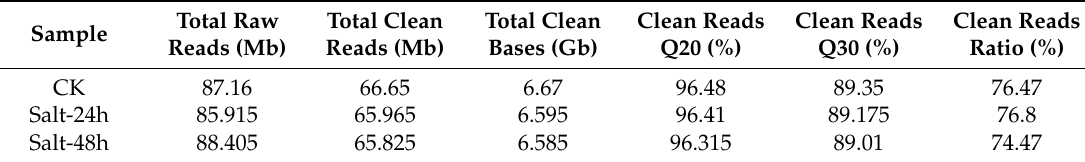
Table 1. Quality statistics of filtered